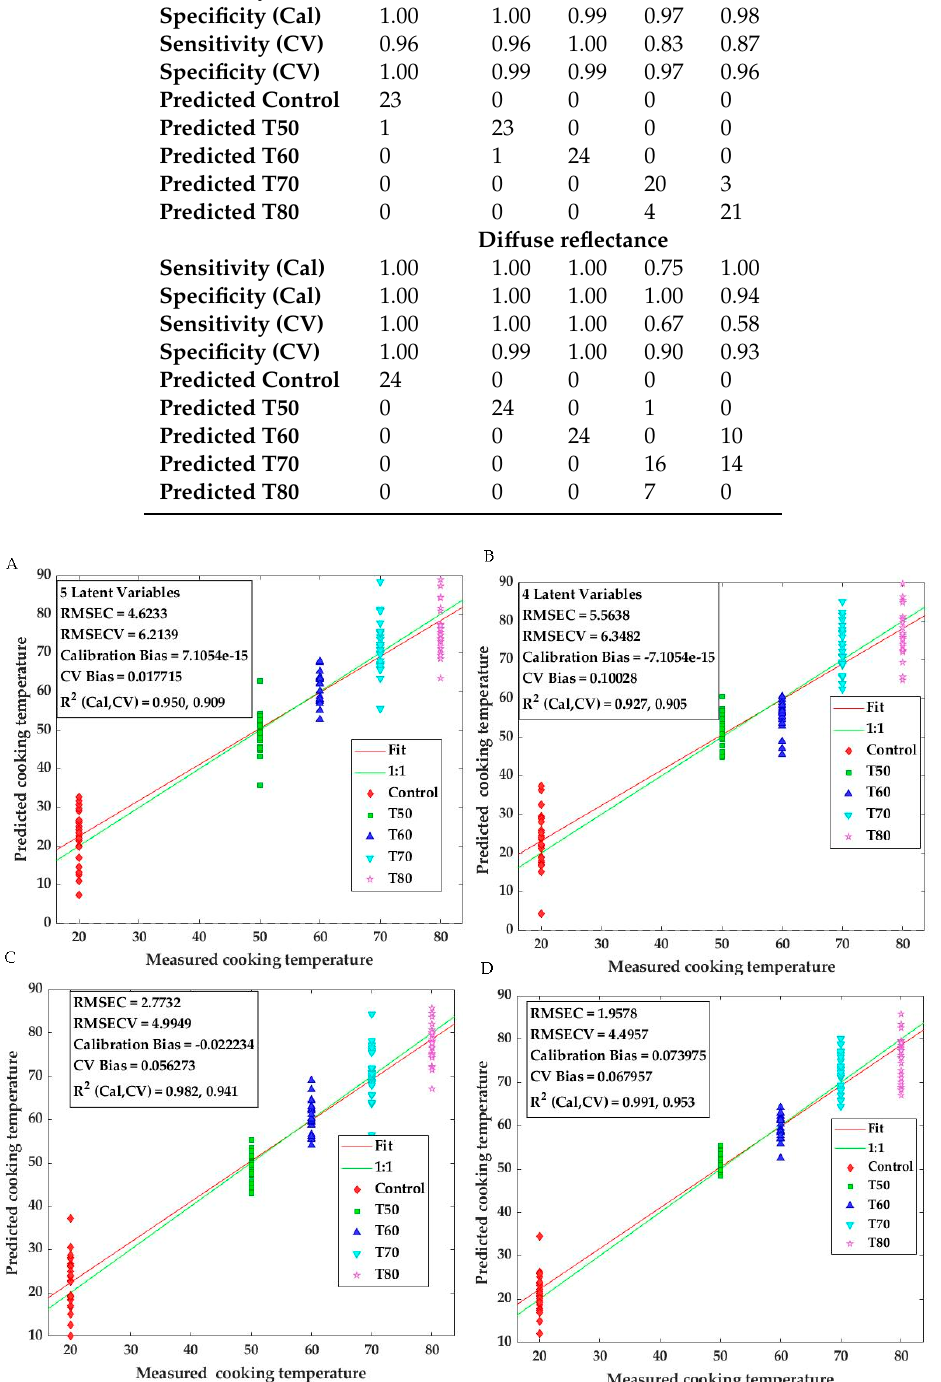
Figure 6. Partial Least Square Regression (PLSR) ( A , B ) and Support Vector Machine Regression (SVMR) ( C , D ) results of predicted cooking temperatures, applied respectively to the fluorescence (A and C) and the di ff use reflectance (B and D) data obtained on the control (T20) and heat treated cod samples as a function of cooking temperatures (T50, T60, T70, T80).